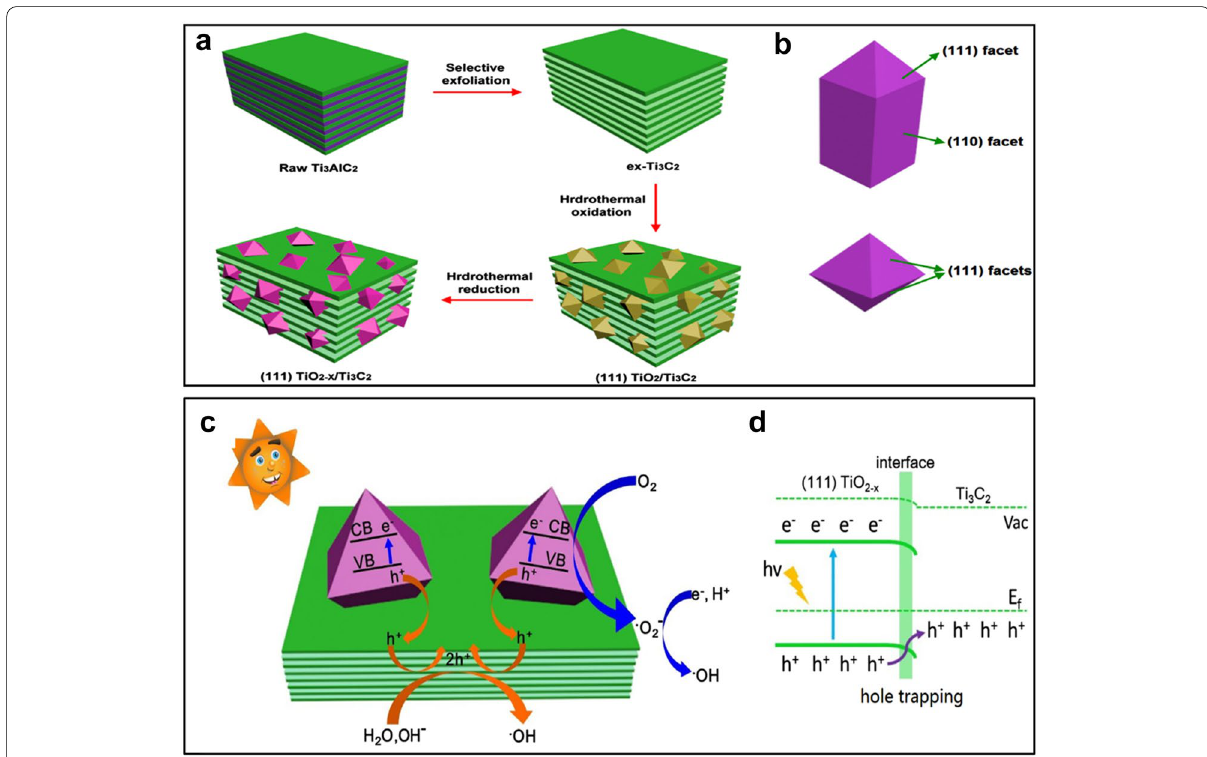
Fig. 5 a Schematic of the formation of (111) TiO 2-x /Ti 3 C 2 nanocomposite with b the crystallographic orientations of rod-like and octahedral rutile. c Photogenerated charge carrier transfer mechanism and d the corresponding band alignments. Reprint with permission [53]. Copyright